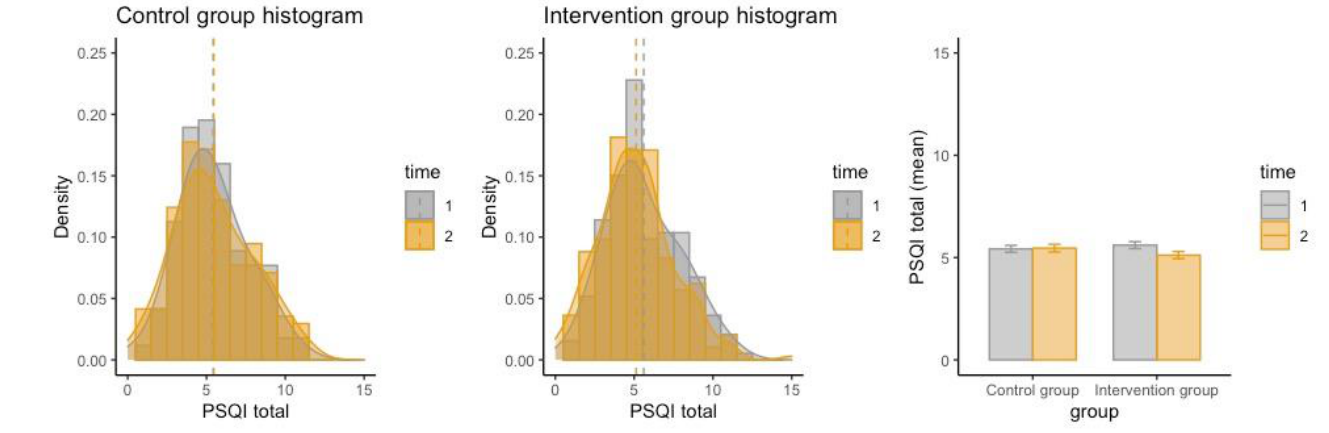
Figure 1. Distributions of pre- and post-intervention PSQI total scores in the two groups. Note. PSQI = Pittsburgh Sleep Quality Index. Time 1 refers to enrolment date; time 2 refers to study end date. The error bars in the bar plot refer to standard errors. Table 2. Pre- and post-intervention level of primary and secondary outcome variables in both groups.